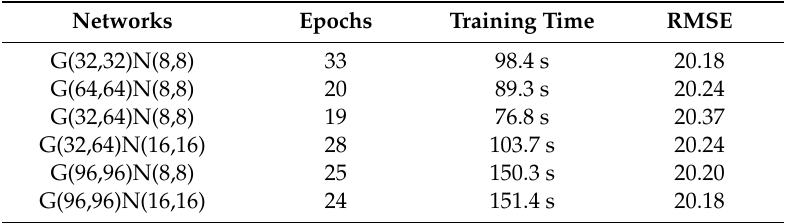
Table 2. Comparison of Root Mean Square Error (RMSE) result (batch size = 32).